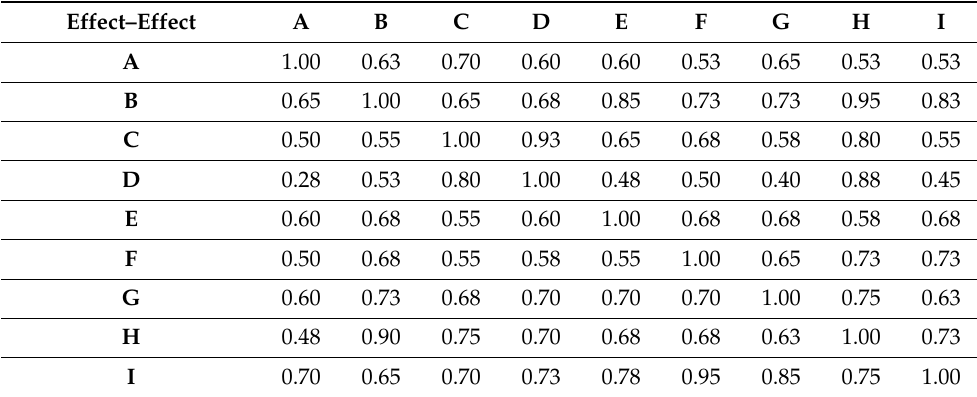
Table 8. Expertons made up of the effect–effect valuation carried out by the group of experts from the tourism sector (Matrix